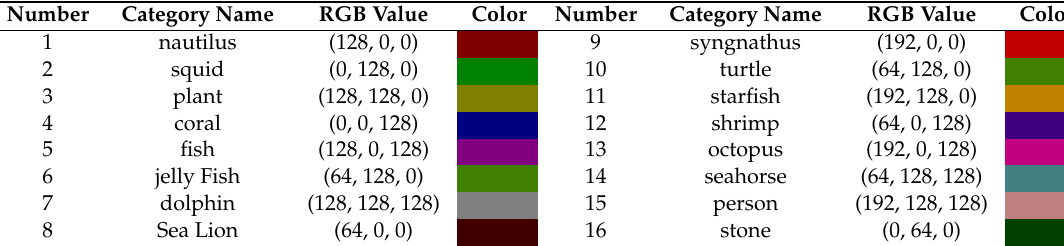
Table 1. Table of category numbers, names and